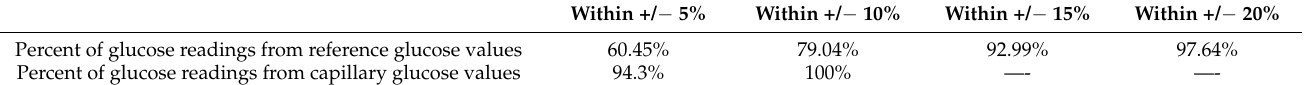
Table 2. Summary of data within specified percent difference from reference glucose values and capillary glucose values.